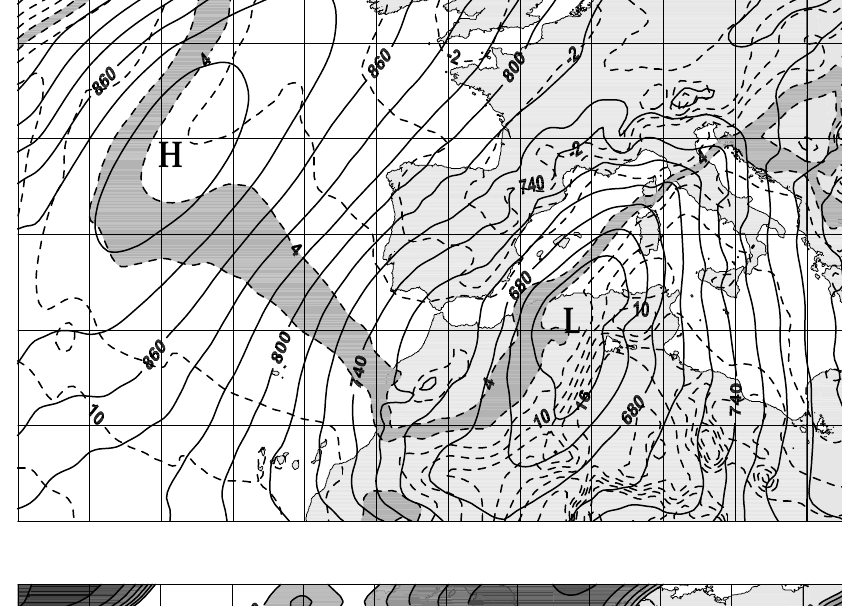
Fig. 10. C20–22 simulation. Geopo- tential height (solid line, 1 =20gpm) and temperature (dashed line, 1 =2 ◦ C) fields at 925hPa, at 00:00UTC, 21December (T+24h). Shaded region corresponds to temperatures between 4 ◦ C and 6 ◦ C